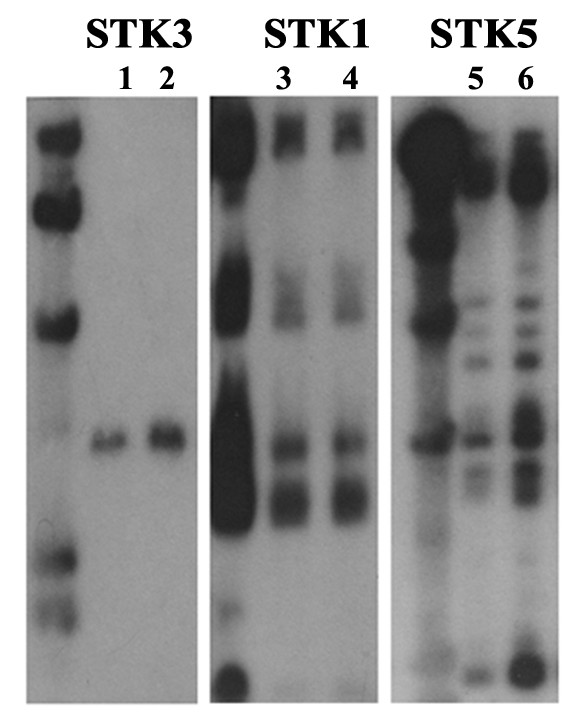
Southern analysis of chestnut rose STK genes. Lane 1, 3, 5: Rosa roxburghii cv. Guinong No.6 which is resistant to powdery mildew disease; Lane 2, 4, 6: R. roxburghii cv. Guinong No.5 which is susceptible to powdery mildew disease. The DNAs were digested with HindIII. DNA size markers (ë/HindIII) are indicated to the left of the image.